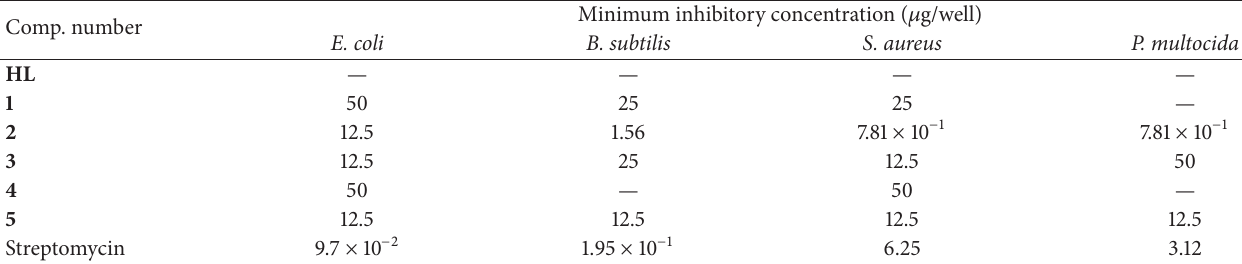
Table 12: MIC (bacterial) of organotin complexes 1–5 .